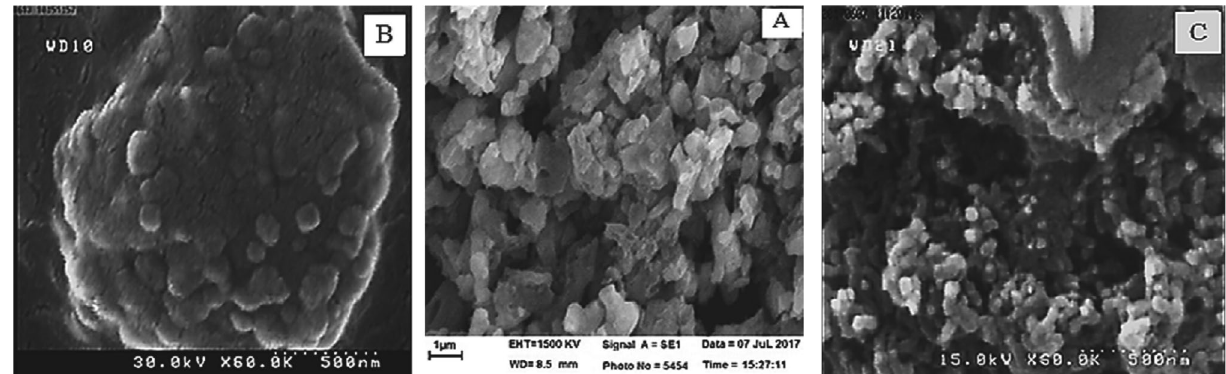
Additionally, VSM analysis of CFNC is shown in Ta- ble 1. The amount of the saturation magnetization (M s ), residual magnetism (M r ) and coercivities (H c ) are 50.5, 23.45 and 848.09 emu g –1 , sequentially. The amount of sat- urated magnetism is based on particles size and is de-